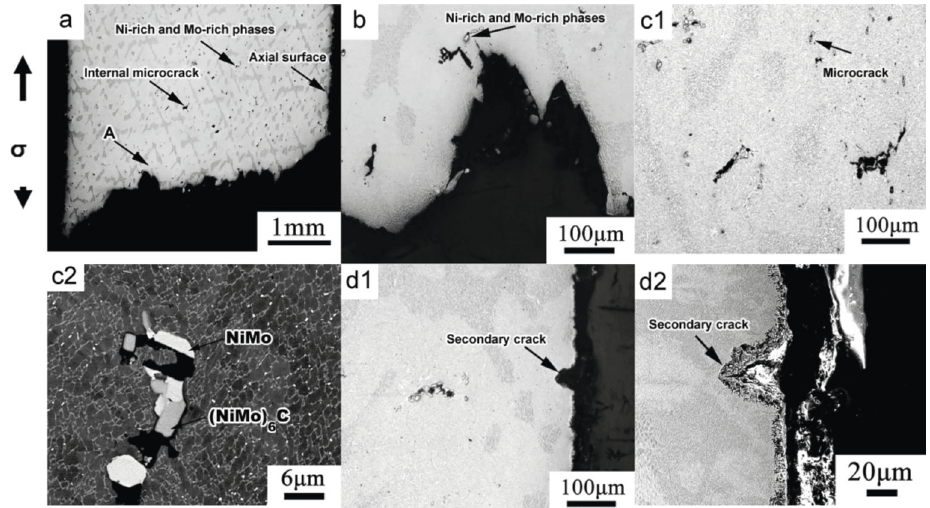
Figure 6: Microstructures of fracture longitudinal section of the single crystal alloy IC6SX with [111] orientation after being crept for 126.9h and then up to fracture at 850 ° C/450 MPa. (a) Macroscopic metallographic structure (OM image); (b) fracture surface cracks (OM image); (c1) microcracks in the interior of the matrix (OM image); (c2) microcracks in the interior of the matrix (SEM image); (d1) secondary crack on the axial surface (OM image); (d2) secondary crack on the axial surface (SEM image).